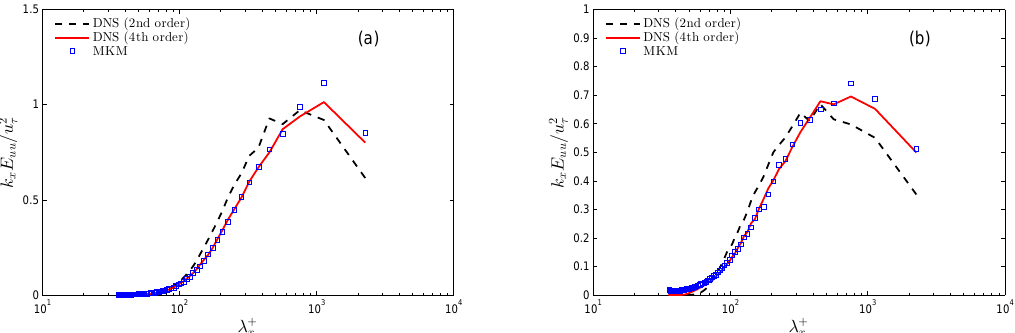
Figure 10. One-dimensional streamwise pre-multiplied spectra k x E uu / u 2 τ at ( a ) y + ≈ 10 and ( b ) y + ≈ 30 of turbulent channel flow at Re τ = 180 by